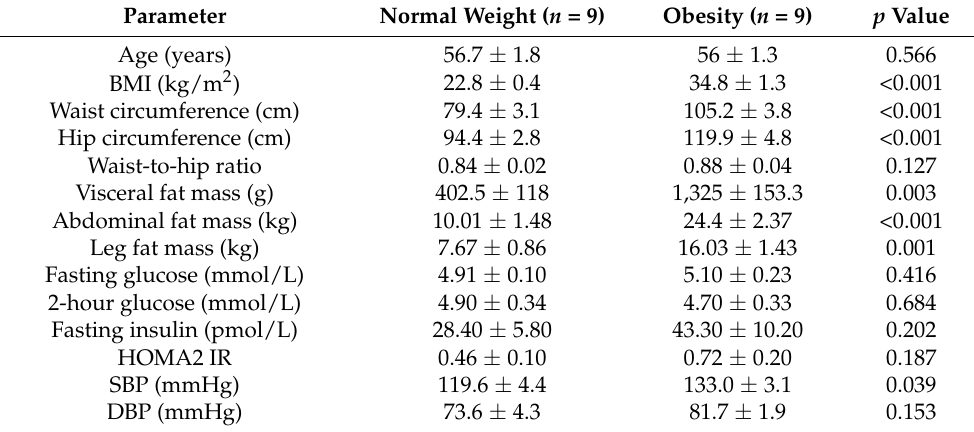
Table 1. Subjects’